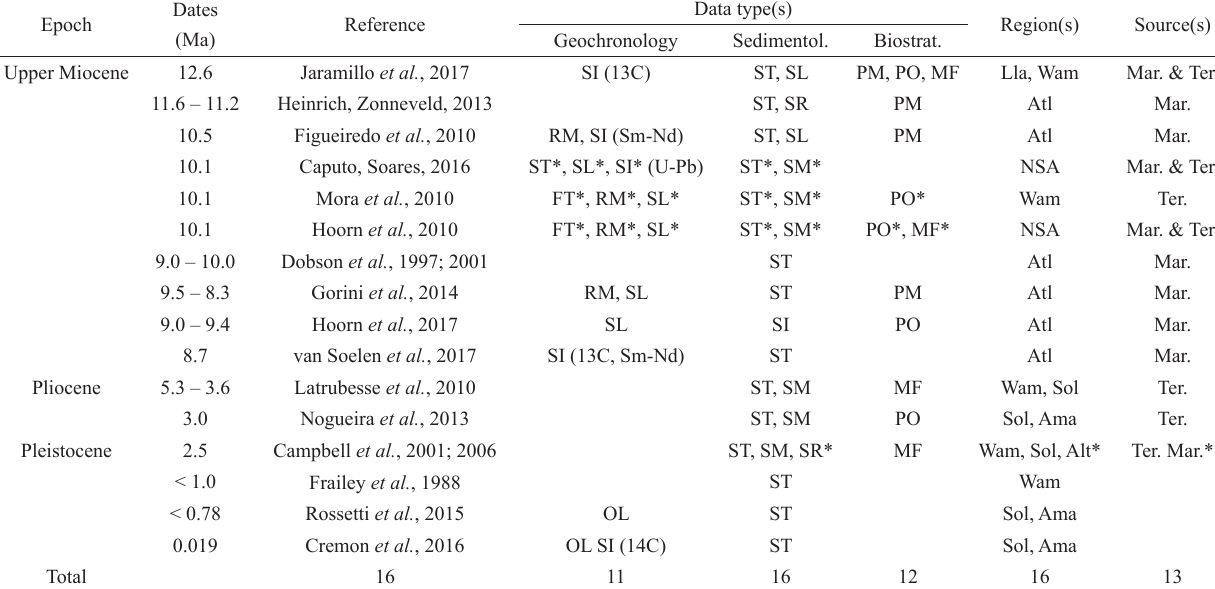
Tab. 1. Summary of literature age estimates for onset of transcontinental Amazon river. Studies arranged by descending order of estimated mega-river capture date. Data types: Geophysics includes data from fission track (FT), radiometric (RM), stable isotopes (SI), and optical luminescence (OL). Sedimentology includes sediment provenance from stratigraphy, lithology, and chemistry (ST), structural mapping (SM), sonic or seismic logging (SL), and sedimentation or subsidence rates (SR). Bios- tratigraphy includes planktonic microfossils (PM), pollen (PO), and macrofossils (MF). Regions: Ama, Amazonas basin; Atl, Atlantic (Amazon fan, Ceará rise); Lla, Llanos basin; NSA, Northern South America; Sol, Solimões basin; Wam, Western Amazon basins. Data sources are terrestrial (Ter) or marine